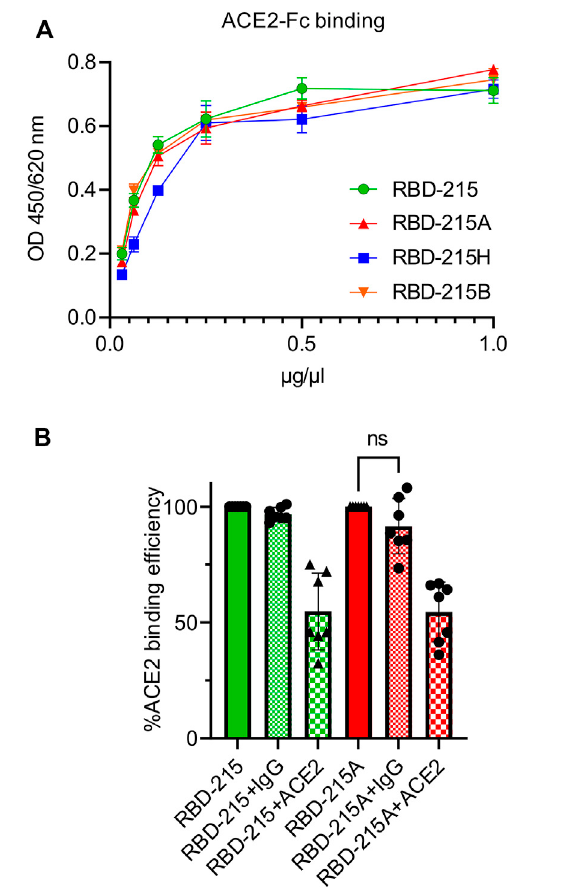
FIGURE 6 | RBD-215 glycoforms display binding to ACE2-Fc. (A) ACE2-Fc binding ELISA. Binding curves of different concentrations of IMAC- puri fi ed RBD-215 glycoforms to plates coated with ACE2-Fc. Values represent the mean ± SD (n (cid:1) 3). (B) ACE2-Fc competition ELISA. RBD- 215 or RBD-215A were premixed with 3-3A anti-blood group A antibody (+IgG) or ACE2-Fc (+ACE2)and addedto ELISAplates coated with ACE2-Fc. Detection wasdonewithanti-His antibodies. Values represent themean ± SD ( n (cid:1) 7). A student ’ s t-test was used to compare the difference in ACE2-Fc binding between RBD-215A and RBD-215A + IgG. “ n.s. ” not signi fi cant ( p (cid:1)